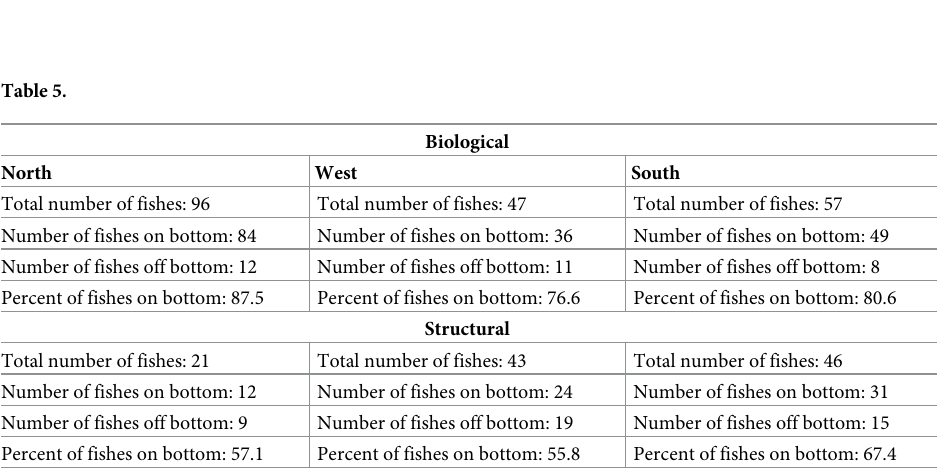
Biological North West South Total number of fishes: 96 Total number of fishes: 47 Total number of fishes: 57 Number of fishes on bottom: 84 Number of fishes on bottom: 36 Number of fishes on bottom: 49 Number of fishes off bottom: 12 Number of fishes off bottom: 11 Number of fishes off bottom: 8 Percent of fishes on bottom: 87.5 Percent of fishes on bottom: 76.6 Percent of fishes on bottom: 80.6 Structural Total number of fishes: 21 Total number of fishes: 43 Total number of fishes: 46 Number of fishes on bottom: 12 Number of fishes on bottom: 24 Number of fishes on bottom: 31 Number of fishes off bottom: 9 Number of fishes off bottom: 19 Number of fishes off bottom: 15 Percent of fishes on bottom: 57.1 Percent of fishes on bottom: 55.8 Percent of fishes on bottom: